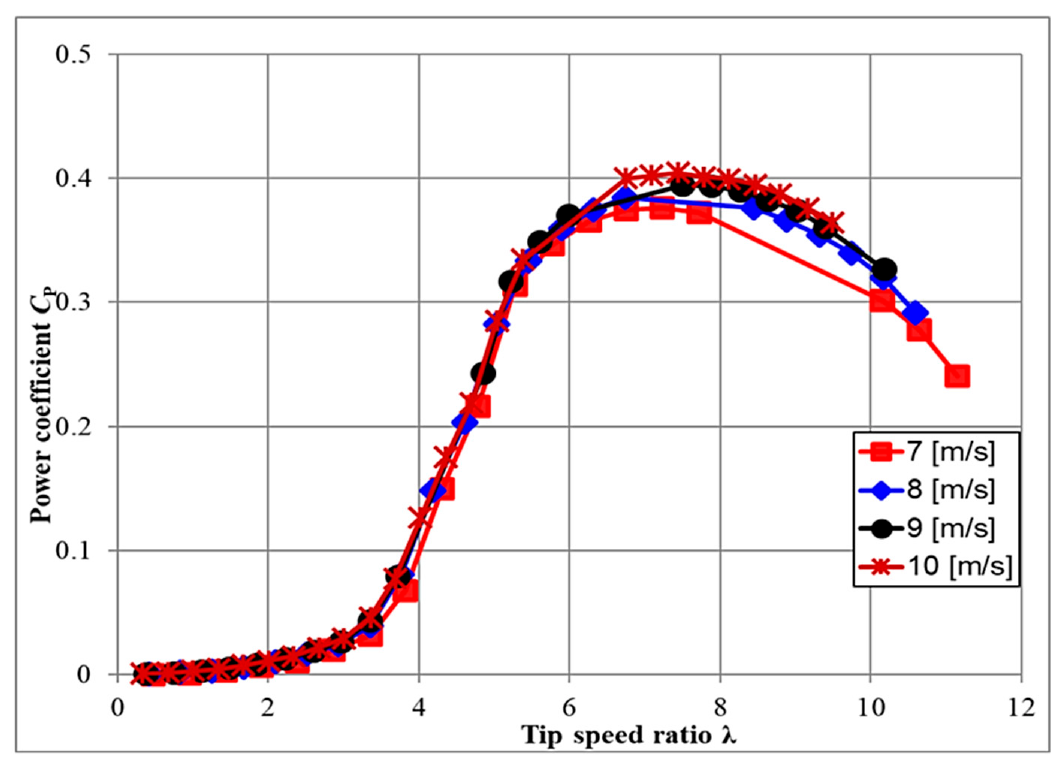
Figure 5. The power coefficient changes under different wind speeds 7, 8, 9 and 10 m/s.